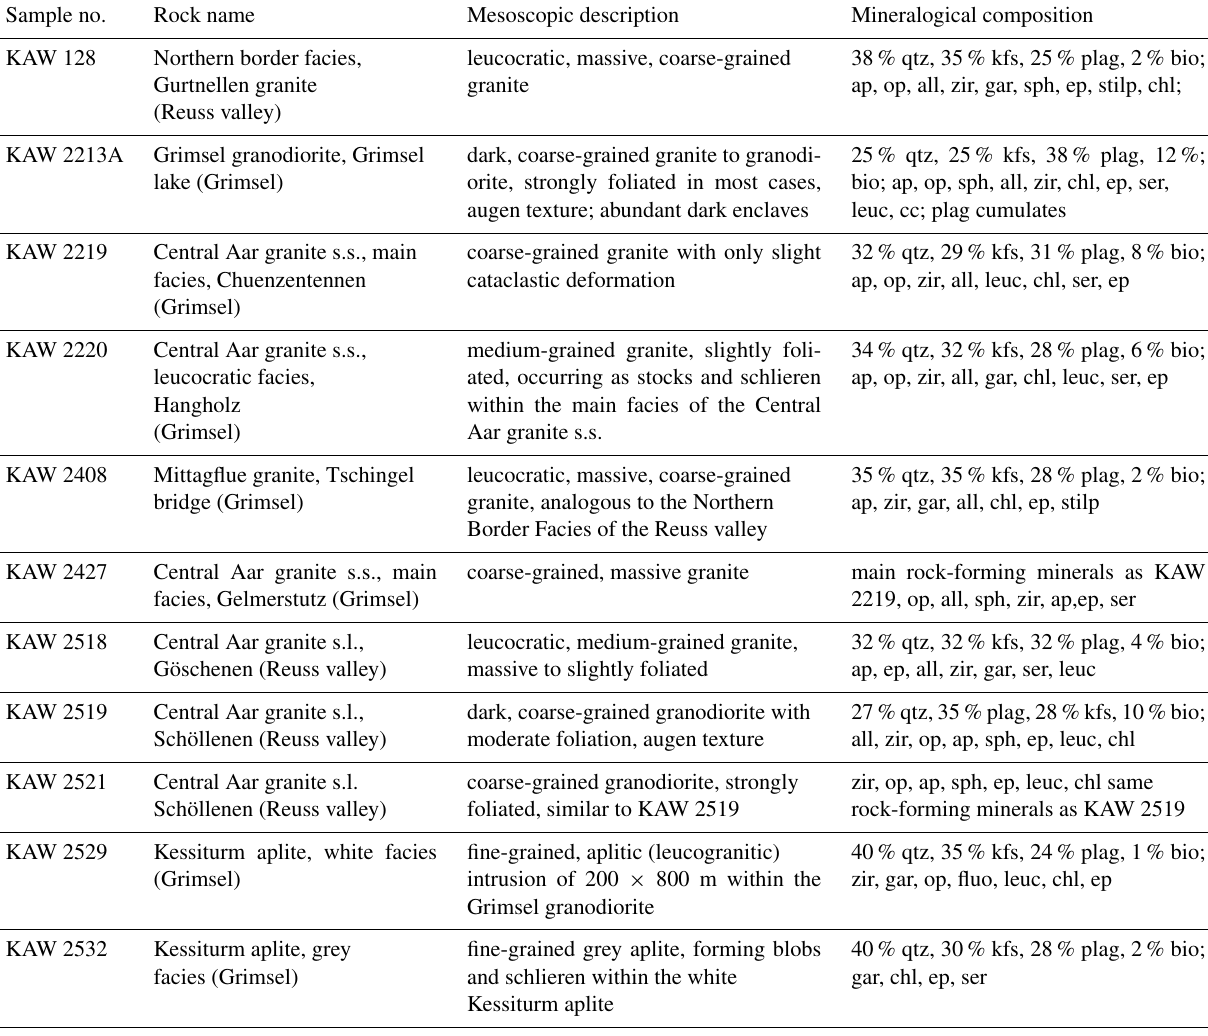
Table 1. Short petrographical descriptions of the rock samples analysed by Schaltegger and Krähenbühl (1990). Compositions are estimated from thin section; all – allanite; ap – apatite; bio – biotite; cc – calcite; chl – chlorite; ep – epidote; fluo – fluorite; gar – garnet; kfs – K-feldspar; leuc – leucoxene; op – opaques; plag – plagioclase; ser – sericite; sph – sphene; stilp – stilpnomelane; qtz – quartz; zir – zircon. The Central Aar granite s.s refers to granitic rocks sampled within the Aar valley, whereas the Central Aar s.l. refers to samples from the same geological unit but that were sampled in the Reuss valley, which is the valley to the east of the Aar valley. Sample